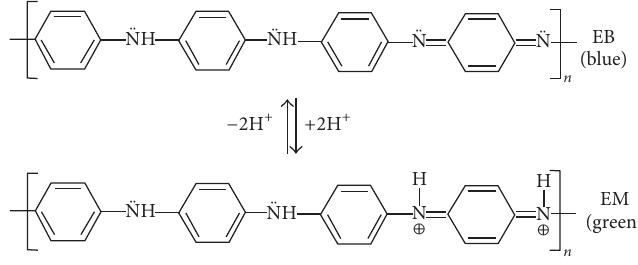
Figure 1: Chemical structure of